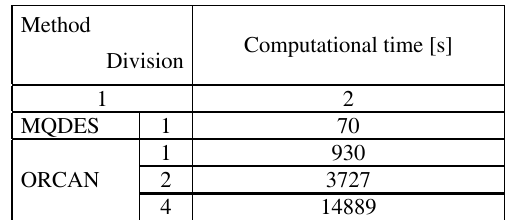
Table 1 . Analysis of computational times